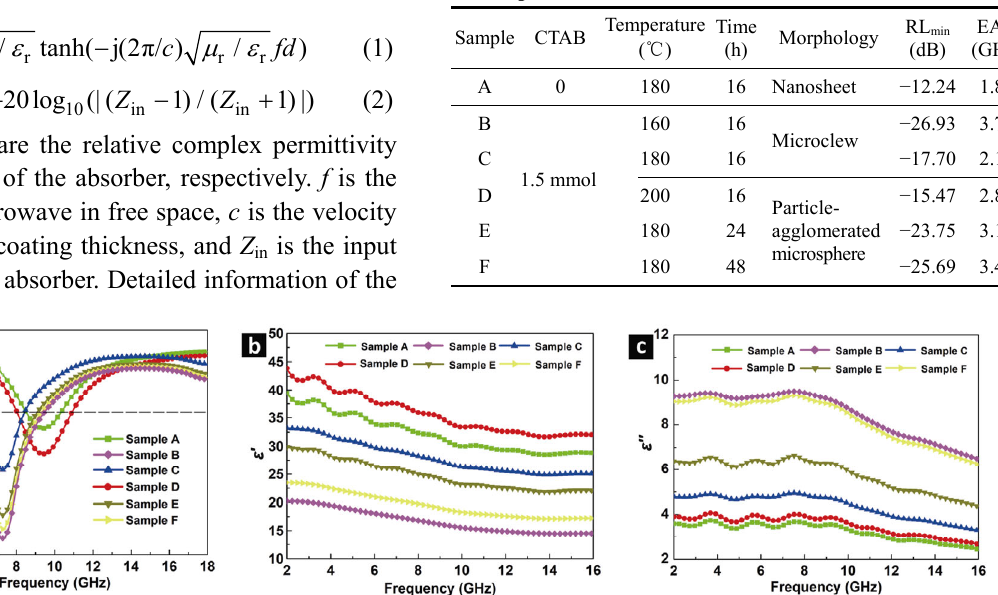
Table 1 Detailed information of the selected CoSe 2 samples for electromagnetic measurements, as well as the absorption performance of the CoSe 2 /epoxy resin